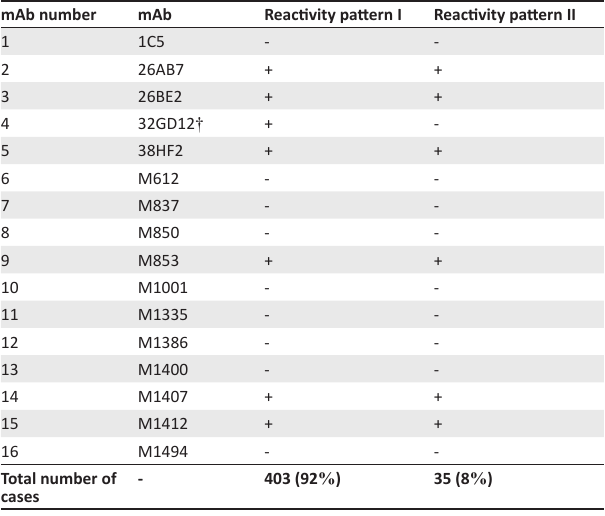
TABLE 4: Indirect immunofluorescence assay reactivity patterns of canid rabies viruses obtained from South Africa. mAb number mAb